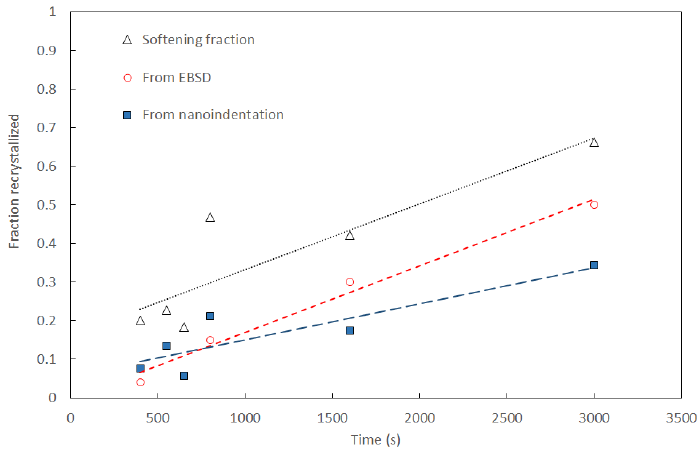
Figure 7. The effect of time on the fraction recrystallized (T = 1550 ◦ C) as measured by nanoindenta- tion and EBSD. Comparison with softening fraction X H computed using the mean hardness value.